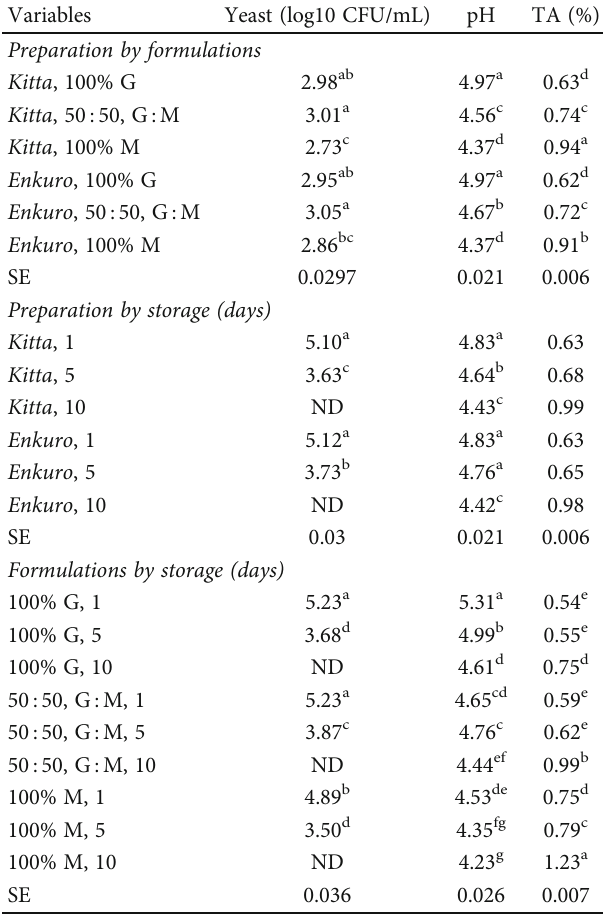
Table 2: Shelf life of tella for di ff erent preparation methods [A], formulations [B], and storage time [C]; values are least square means with standard errors as error bars and those with di ff erent connecting letters are signi fi cantly di ff erent ( p < 0 : 05